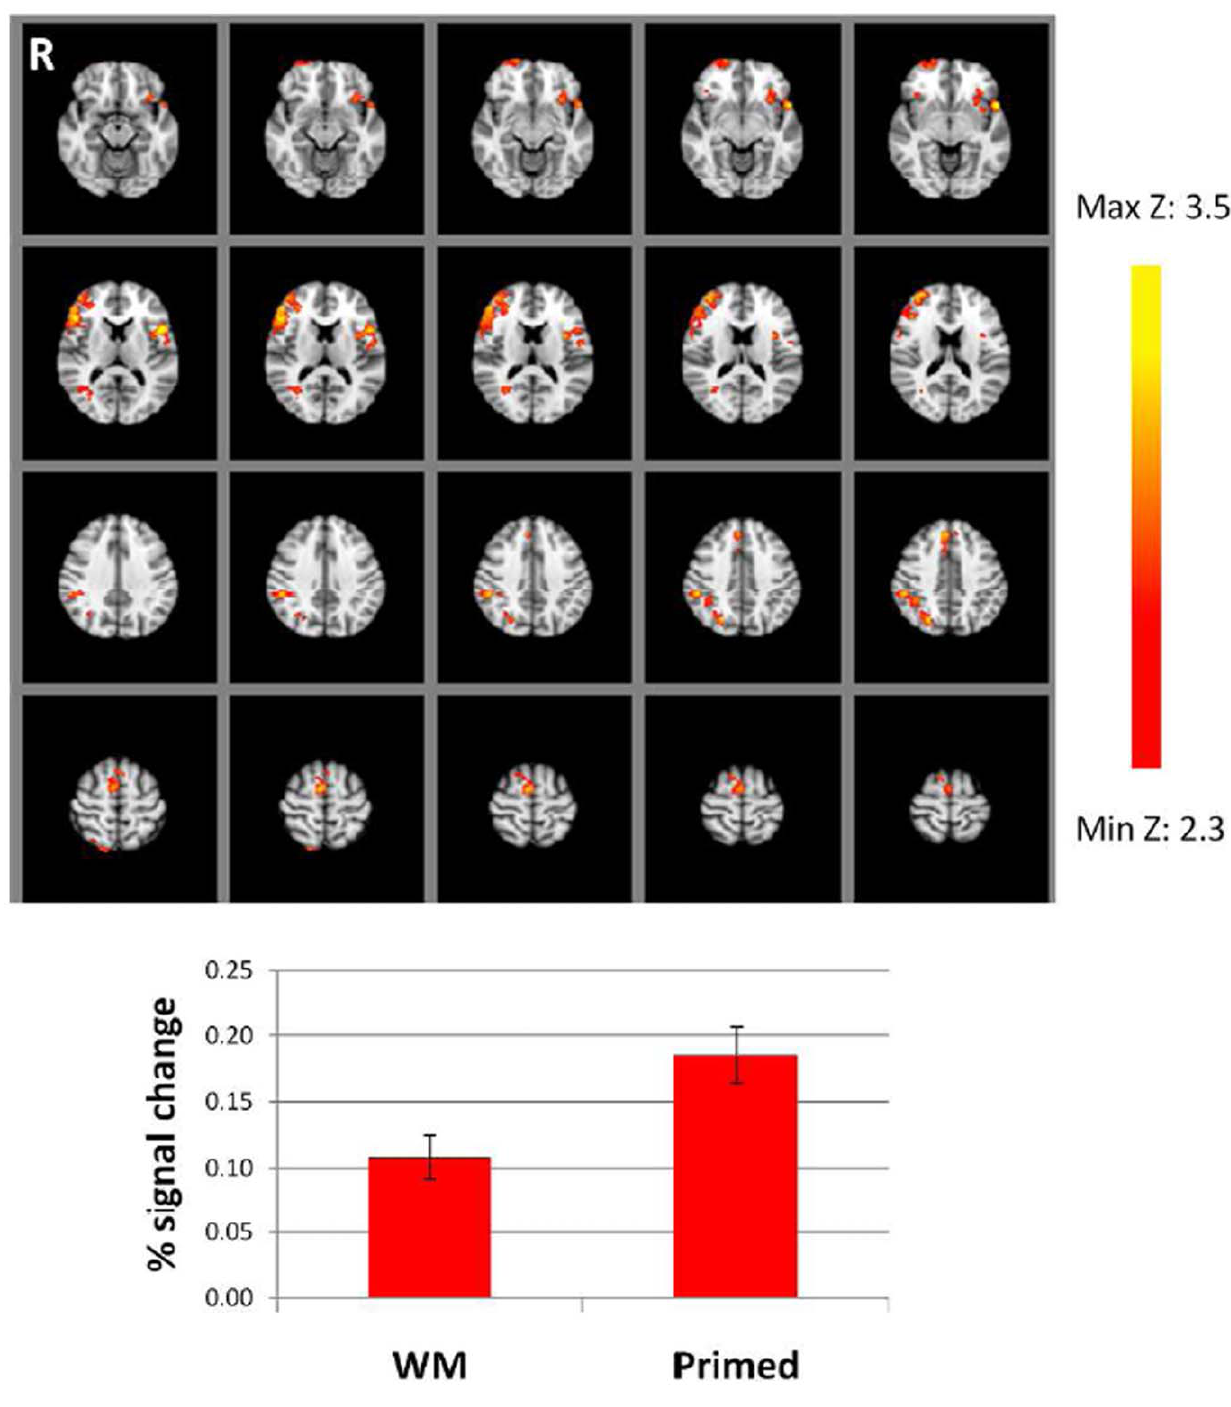
Figure 5. Data from Experiment 2. Percentage signal change in paired repeats relative to the unpaired baseline. Regions showing repetition enhancement common to both WM and Primed conditions. Z=2.3, p , .05, corrected for multiple comparisons. Images are in radiological orientation (right=left).